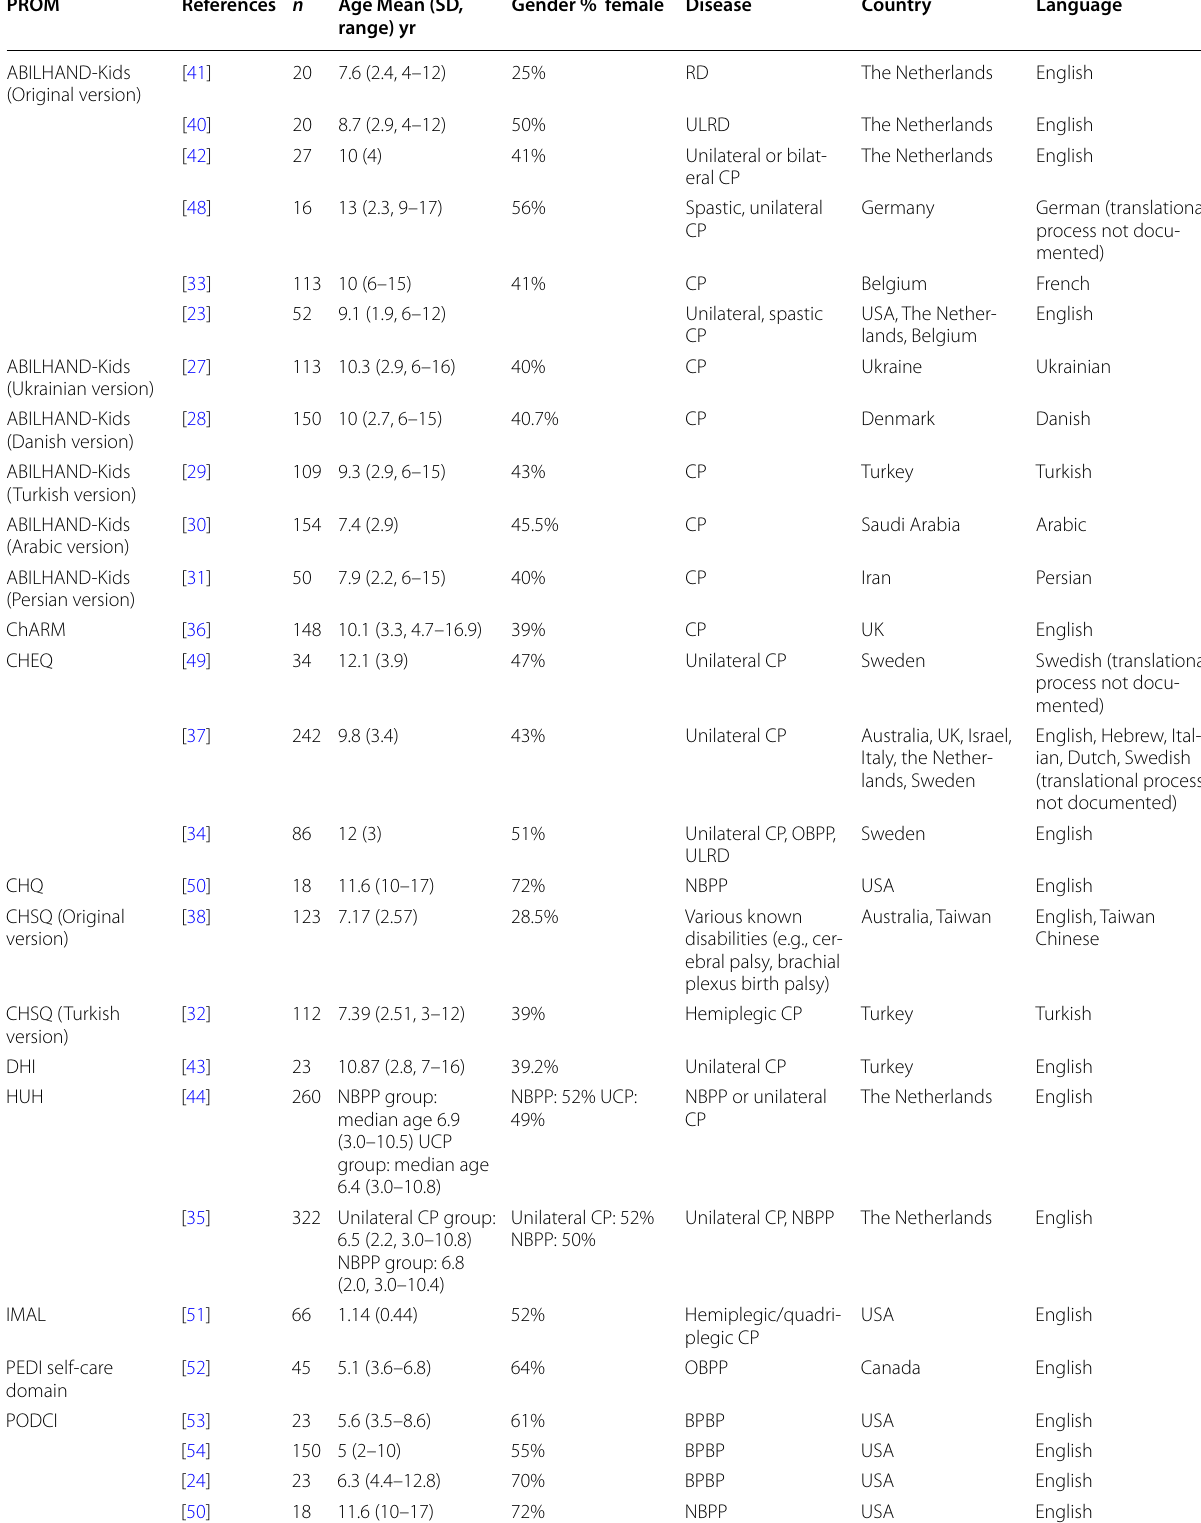
Table 1 Characteristics of the included